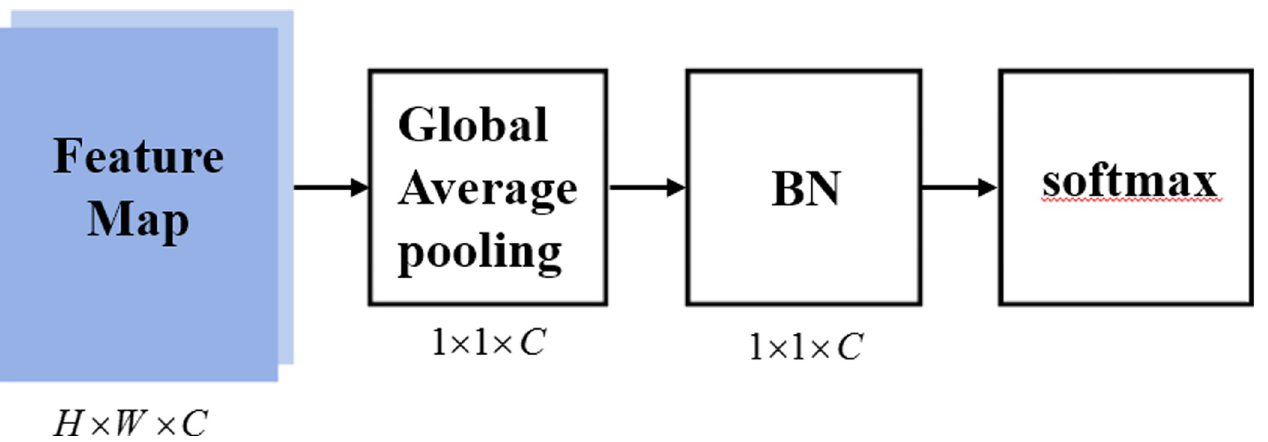
Fig 6. The classification